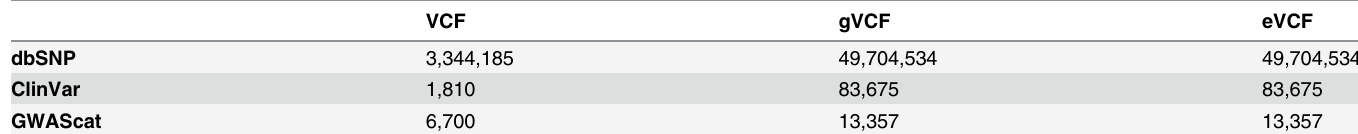
Table 7. Comparison of the number of dbSNP, ClinVar and GWAScat sites represented using VCF, gVCF and eVCF